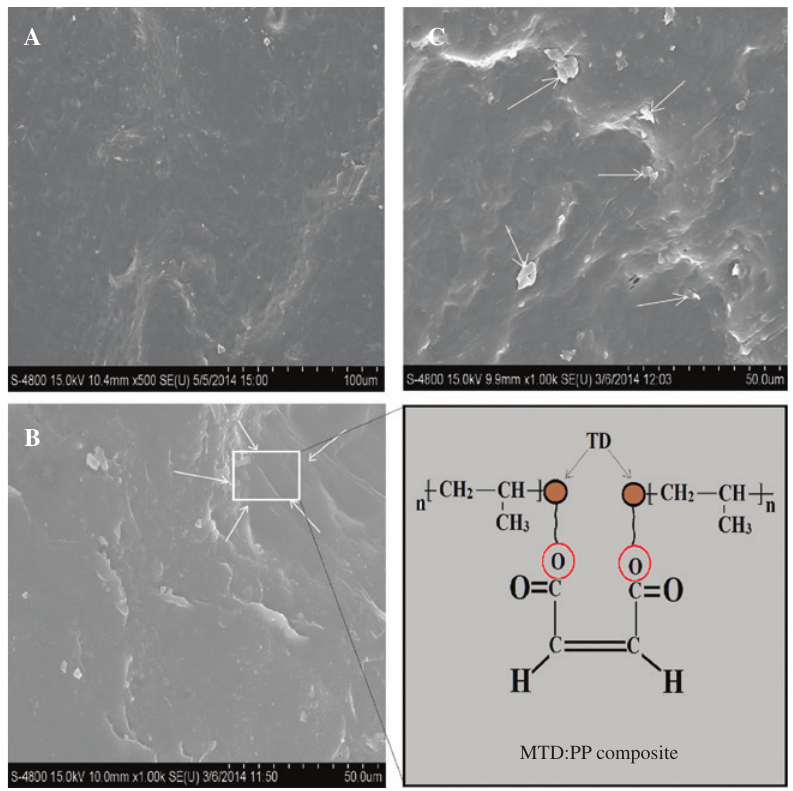
Figure 4: FE-SEM images (A) PP (B) MTD:PP and (C) UTD:PP